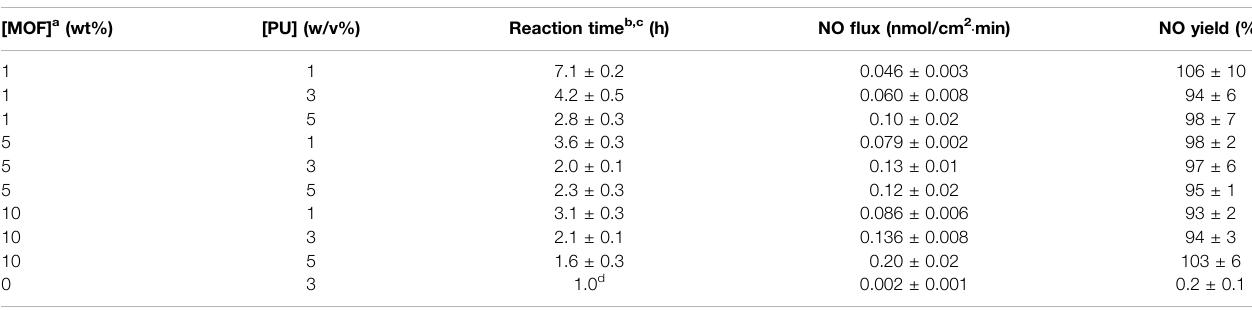
TABLE 3 | Composite fi lms comparing MOF loading and polymer